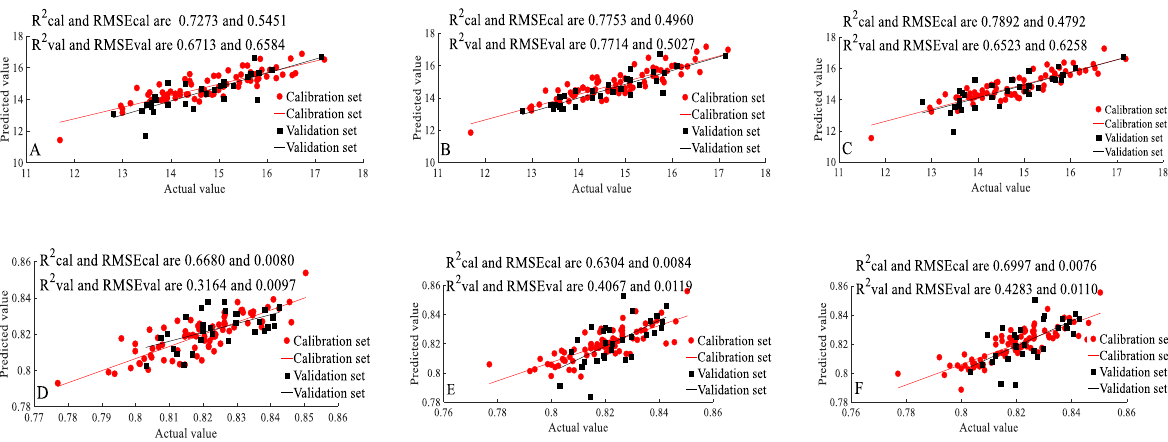
Figure 6. TSSC and water content detection based on MIF data. ( A , D ) whole spectral data 400–1700 nm, ( B , E ) VIS/NIR and machine vision fusion, ( C , F ) VIS/NIR and E-nose fusion, ( A – C ) TSSC detection, ( D –F) water content detection.